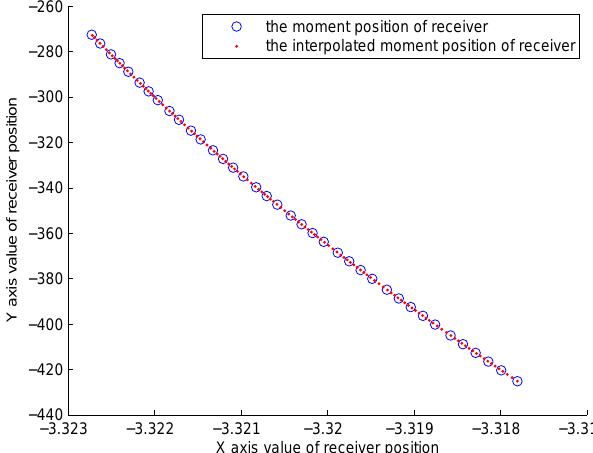
Figure 2. Receiver path before and after spline interpolation.